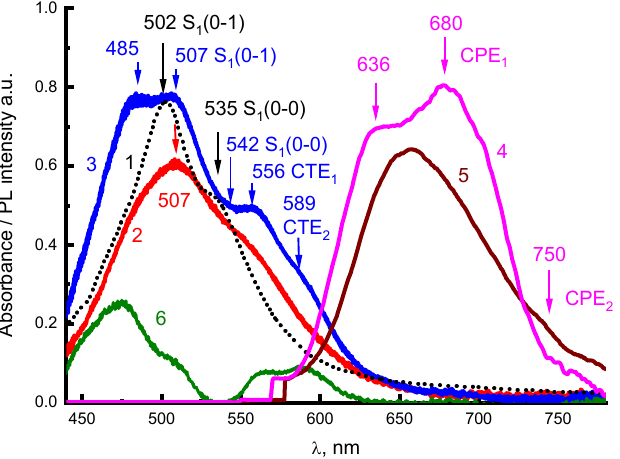
Figure 4. Absorption (1–3) and steady-state PL (4,5) of aqueous solution (1) of 2416SL at the con- centration of 5 · 10 − 6 M (1) and 2416SL films before (2,5) and after thermal annealing at 470 K (3,4); differential spectrum, ∆ , (6) obtained by subtraction of the spectrum (2) from the spectrum (3). λ e = 405 nm; T = 296